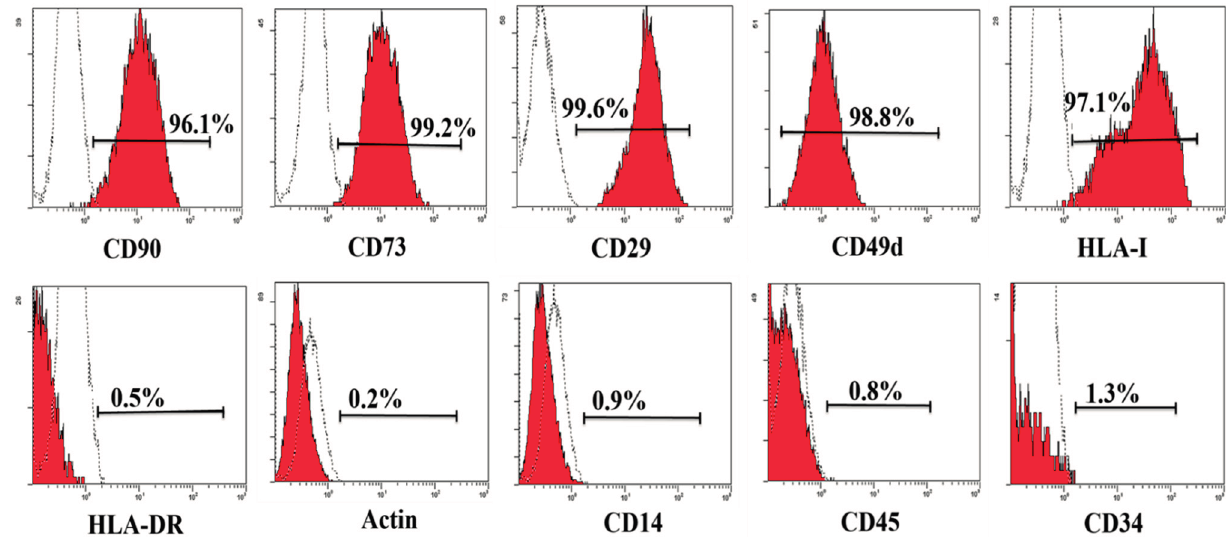
Figure 1. Phenotype of haMPCs. The haMPCs are positive for CD90, CD73, CD29, CD 49d and HLA-I, negative for CD45, CD14, CD34, HLA-DR and Actin.